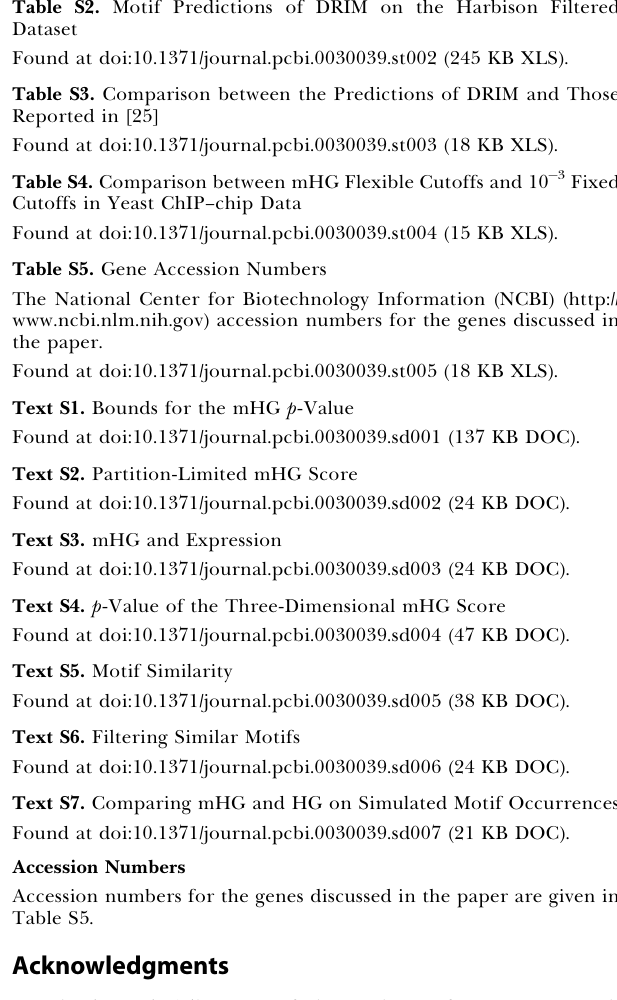
Figure S1. Observed versus Expected Length Bias Figure S2. Comparison of p- Value Bounds, Exact p -Value Calculation, and Observed Frequencies of mHG Scores for Two Synthetic Cases: